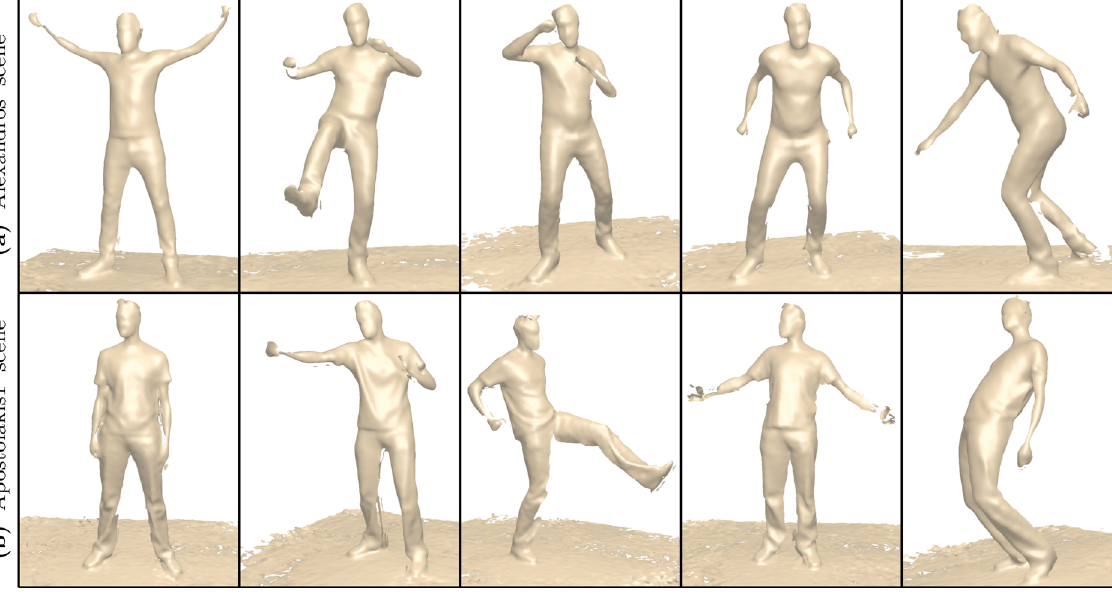
Fig. 10 Reconstruction of human actors in various poses. Capture data is courtesy of Alexiadis et al. [21]. Above: part of “Alexandros” scene. Below: part of “Apostolakis1” scene. In general, the models are correctly reconstructed. However, some smaller details are missing due to lack of visibility from